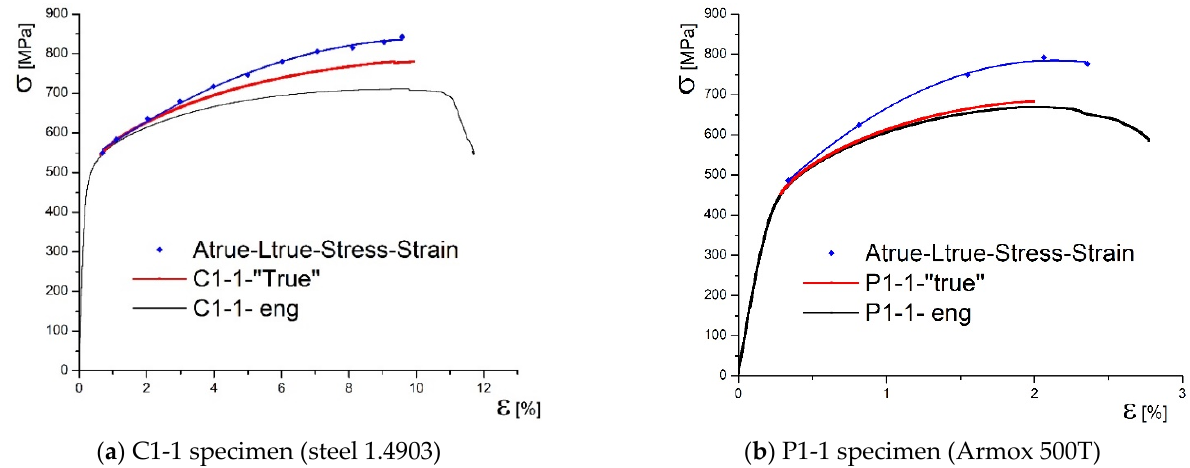
Figure 6. Comparison of true and engineering diagrams calculated by DIC method.